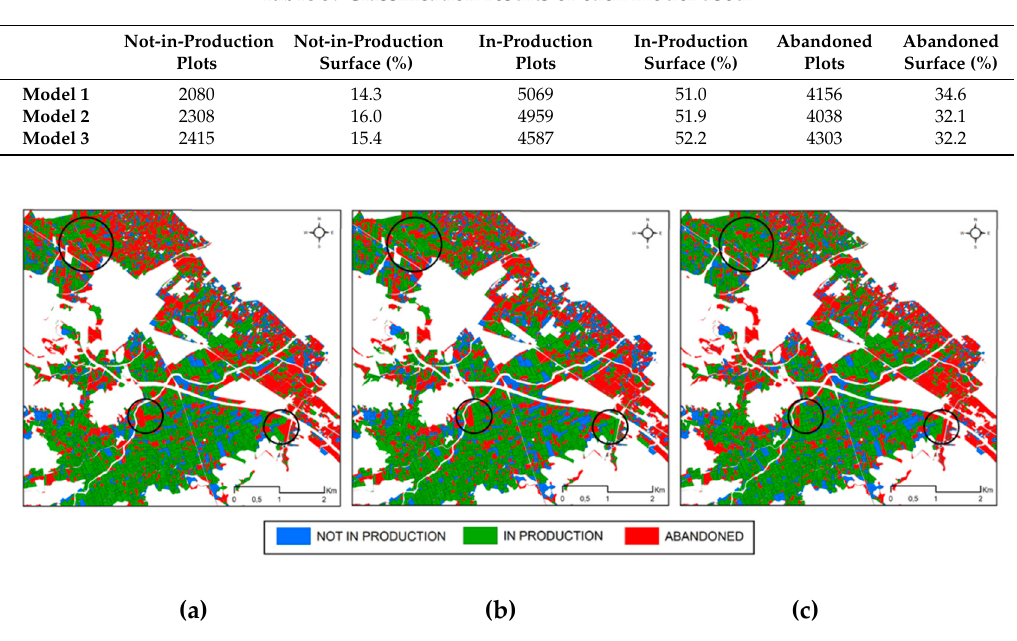
Table 3. Classification results of each model used.